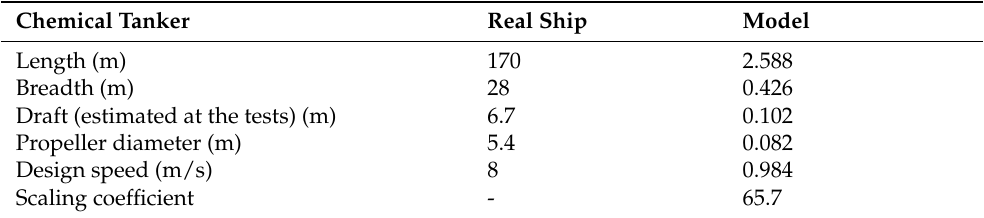
Figure 1. Photo of the chemical tanker model. Table 1. Main dimensions of the real ship and model.